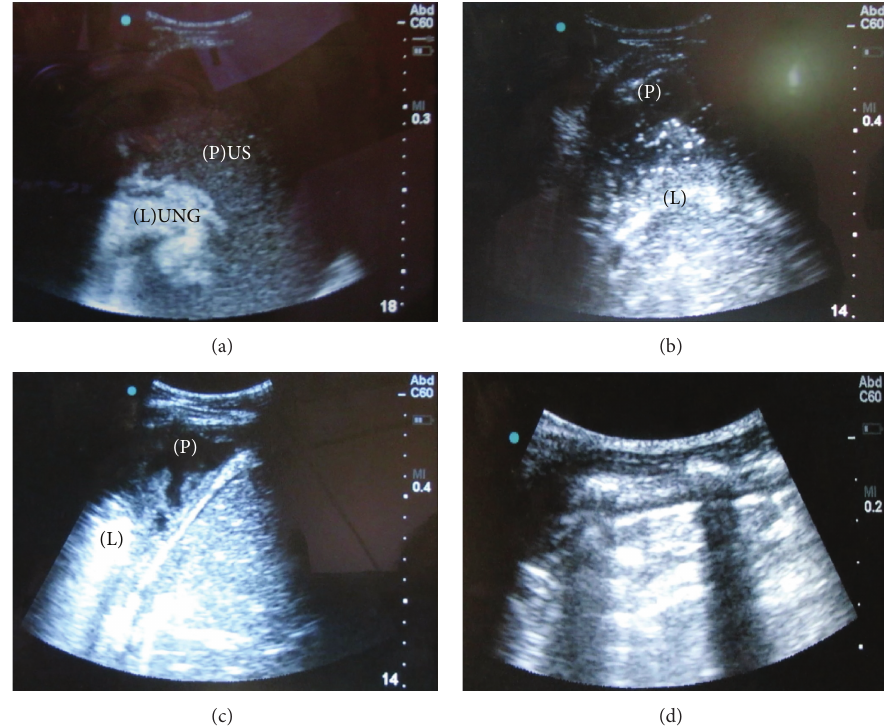
Figure 1: (a) The initial ultrasound demonstrating a large amount of fluid in the pleural space and a collapsed lung. (b) An ultrasound one day after the drain was placed demonstrating decreased fluid in the pleural space. (c) An ultrasound three days after the drain was placed demonstrating even less fluid and improved lung expansion. (d) An absent sliding sign on the affected hemithorax.